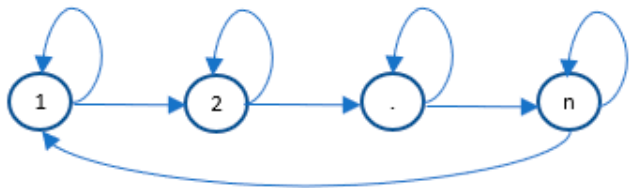
Figure 3. Deterministic finite automaton as a communication model.